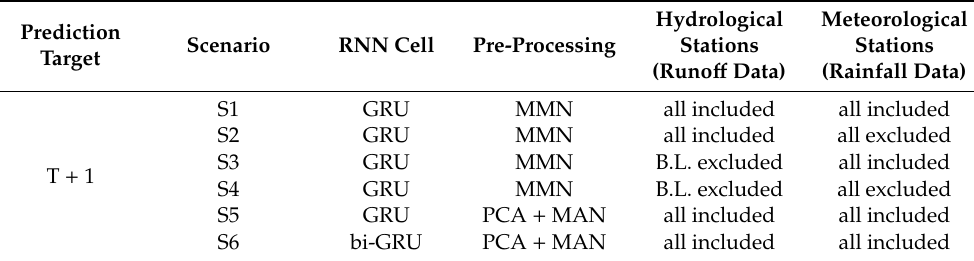
Table 3. Summary of the setting condition of